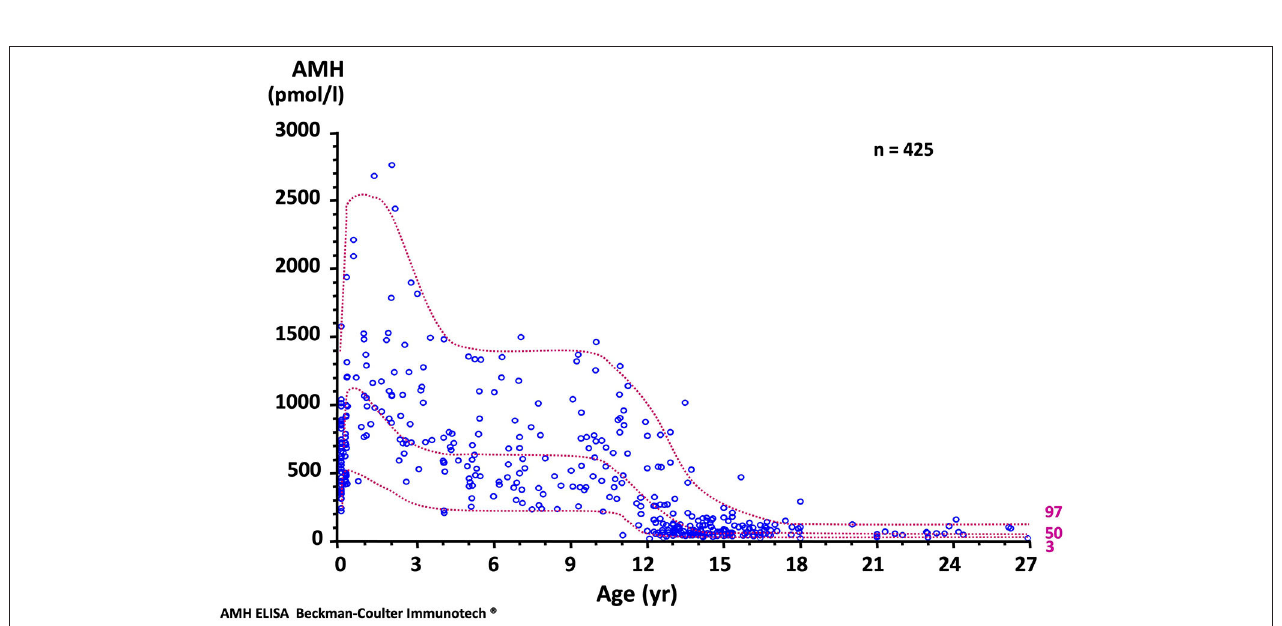
FIGURE 3 | Serum AMH levels in normal males. The dotted lines represent the 97, 50, and 3rd percentiles. To obtain serum AMH in ng/mL, divide by 7.14. Reproduced with permission from ref. (22). Copyright © The Author(s) 2011.